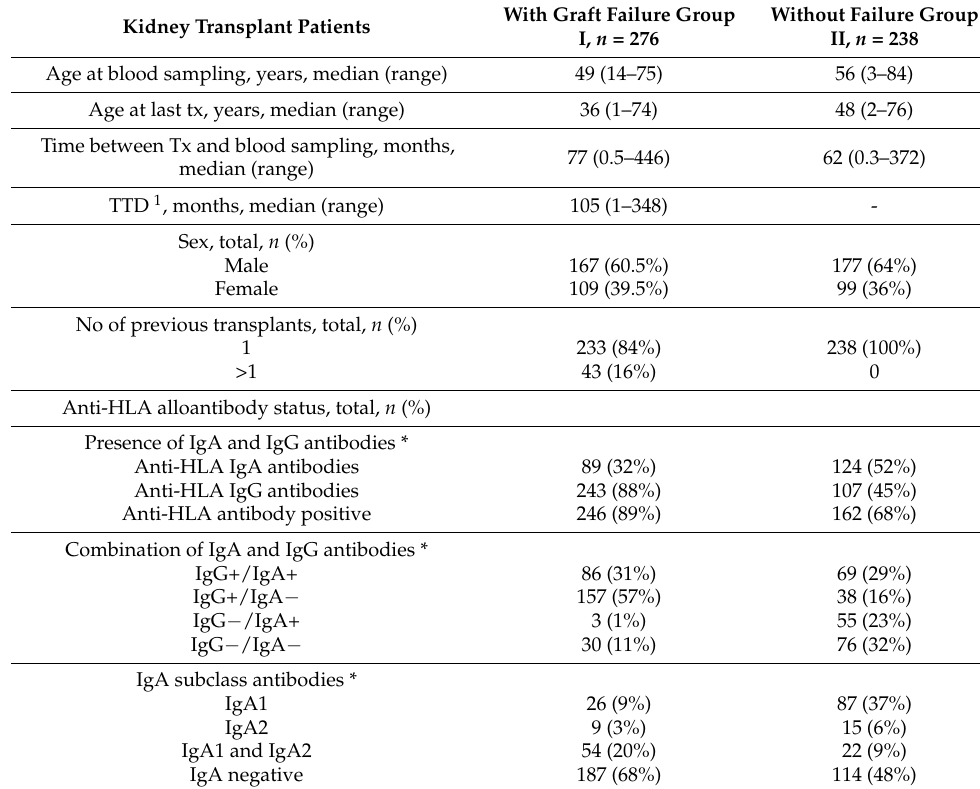
Table 1. Demographics of kidney transplant